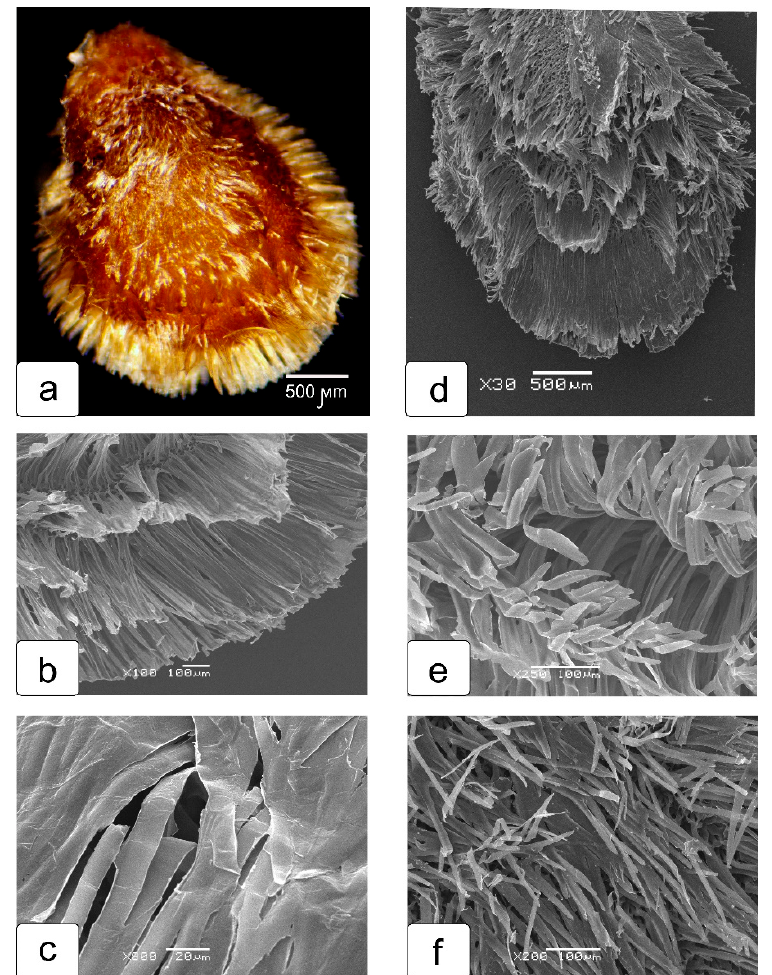
Figure 9. Stages of seed coat formation with ribbon-like hairs. Seed removed from the seed capsule and washed ( a ). The same seed on a scanning electron microscope ( d ). Gradual divergence (fluffing) of the cell walls into separate ribbons ( b , c , e ), which then take the form of hairs ( f ).